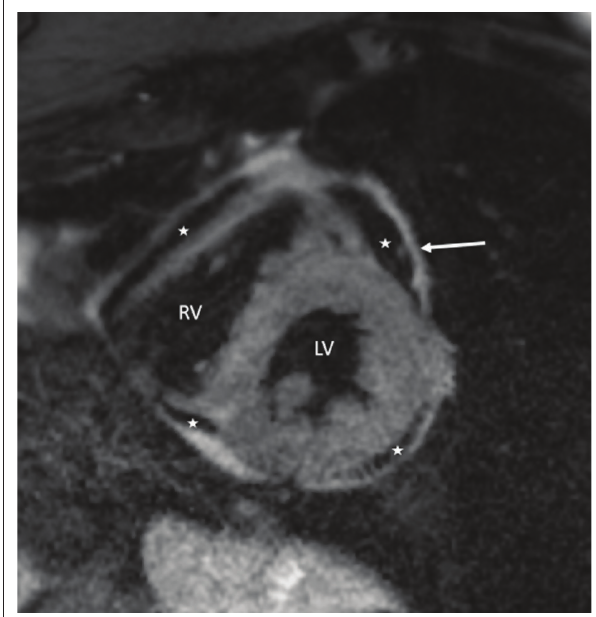
RV, right ventricle; LV, left ventricle. FIGURE 5: A 62-year-old man with constrictive pericarditis. The short-axis STIR image demonstrates a loculated pericardial effusion ( * ) and thickened hyper- intense pericardium (white